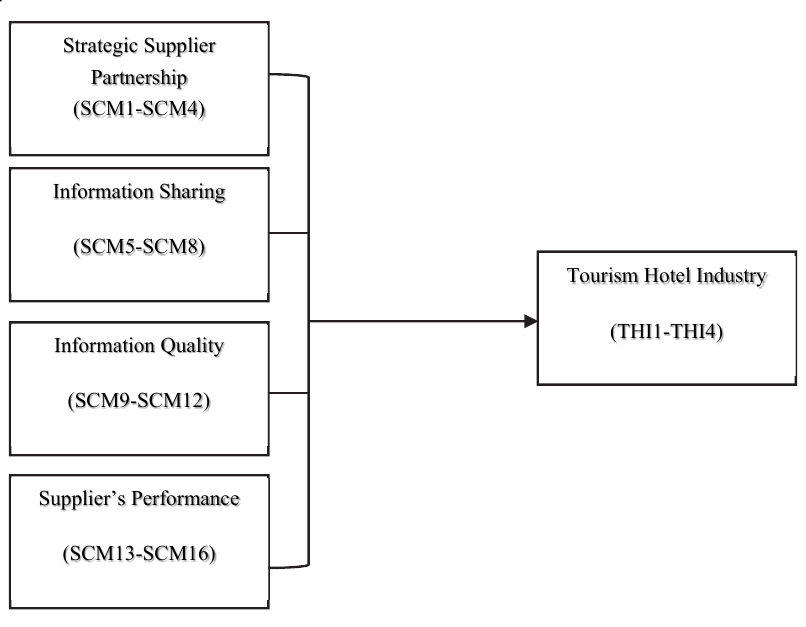
Fig. 2. Model of the Study